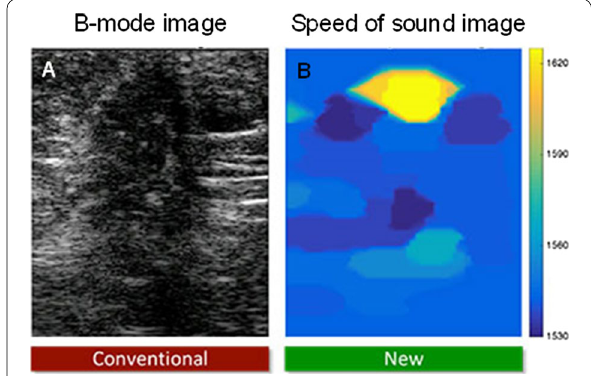
Fig. 10 a B-mode image of an 88-year-old woman with a breast cancer. b Speed of sound map computed within the selected